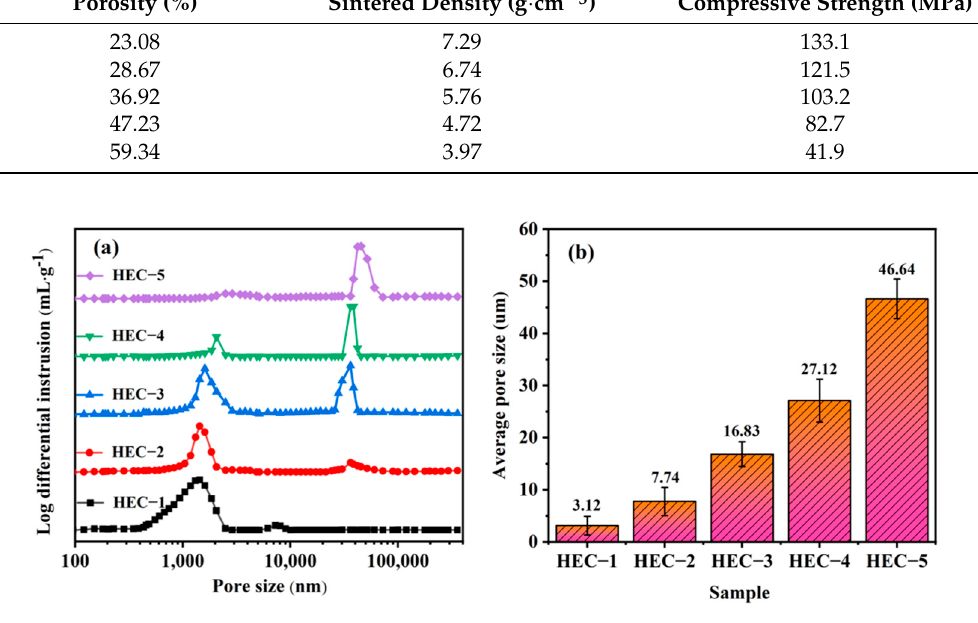
Figure 6. ( a ) Pore-size distributions and ( b ) average pore diameters of the porous HECs with the various amounts of pore-forming